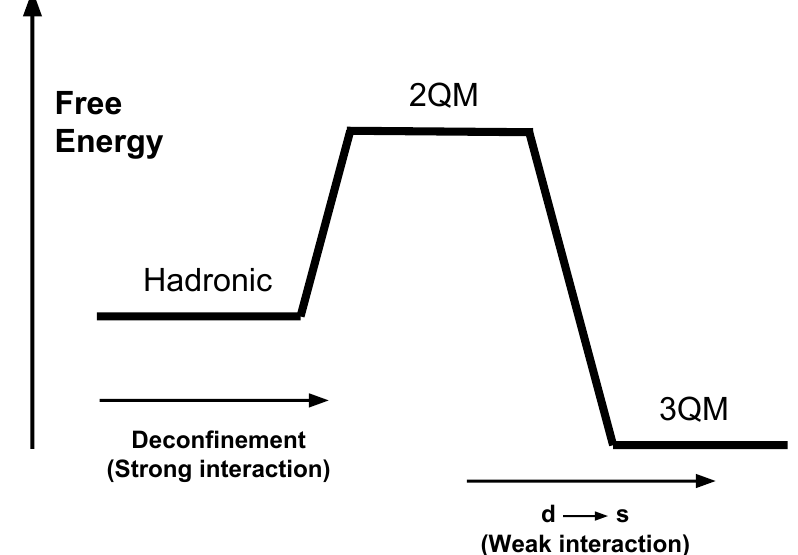
Figure 1. Free energy (Helmholtz) diagram of the conversion process of hadronic to three flavoured quark matter (3QM). Hadronic matter deconfines to two flavoured quark matter (2QM) through the strong interaction, while 2QM decays to 3QM through the nonleptonic process d → s (for the case of deleptonized matter, otherwise there are leptonic processes as well). Notice how the hadronic matter needs to be injected with energy before deconfinement becomes favorable. In the context of a compact object, the high energy is acquired through the high Fermi momenta of the dense hadronic matter. After the hadronic matter is deconfinement into 2QM matter, the weak interaction can lower its energy to absolutely stable 3QM. Figure and caption were taken from Ouyed’s PhD thesis